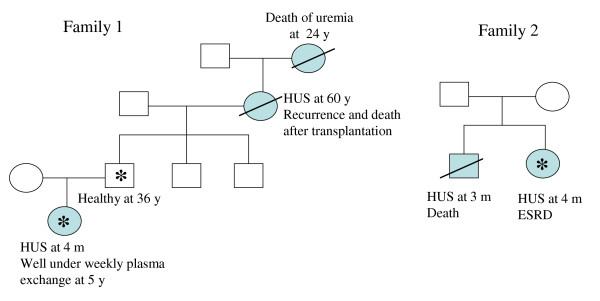
Mode of transmission and intrafamilial phenotype variability of atypical hemolytic uremic syndrome: example from two families with heterozygous CFH mutation. CFH mutation: W1183R, SCR 20 (Family 1); W1183L, SCR 20 (Family 2). Notice i) the autosomal dominant (Family 1) or recessive (Family 2) mode of inheritance of the disease ii) the intrafamilial phenotype variability and incomplete penetrance in Family 1. Affected individuals are indicated with filled symbols. Deceased individuals are crossed. Carriers of the CFH mutation are indicated by an asterisk. Courtesy of Professor G. Deschênes (Hôpital Robert Debré, Paris), with permission.